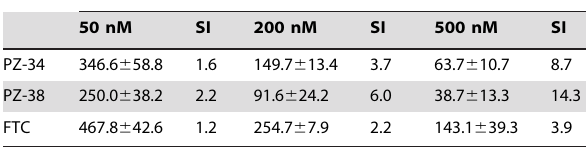
Table 2. Sensitization index of PZ-34 and PZ-38 on mitoxantrone resistance in HEK293/ABCG2